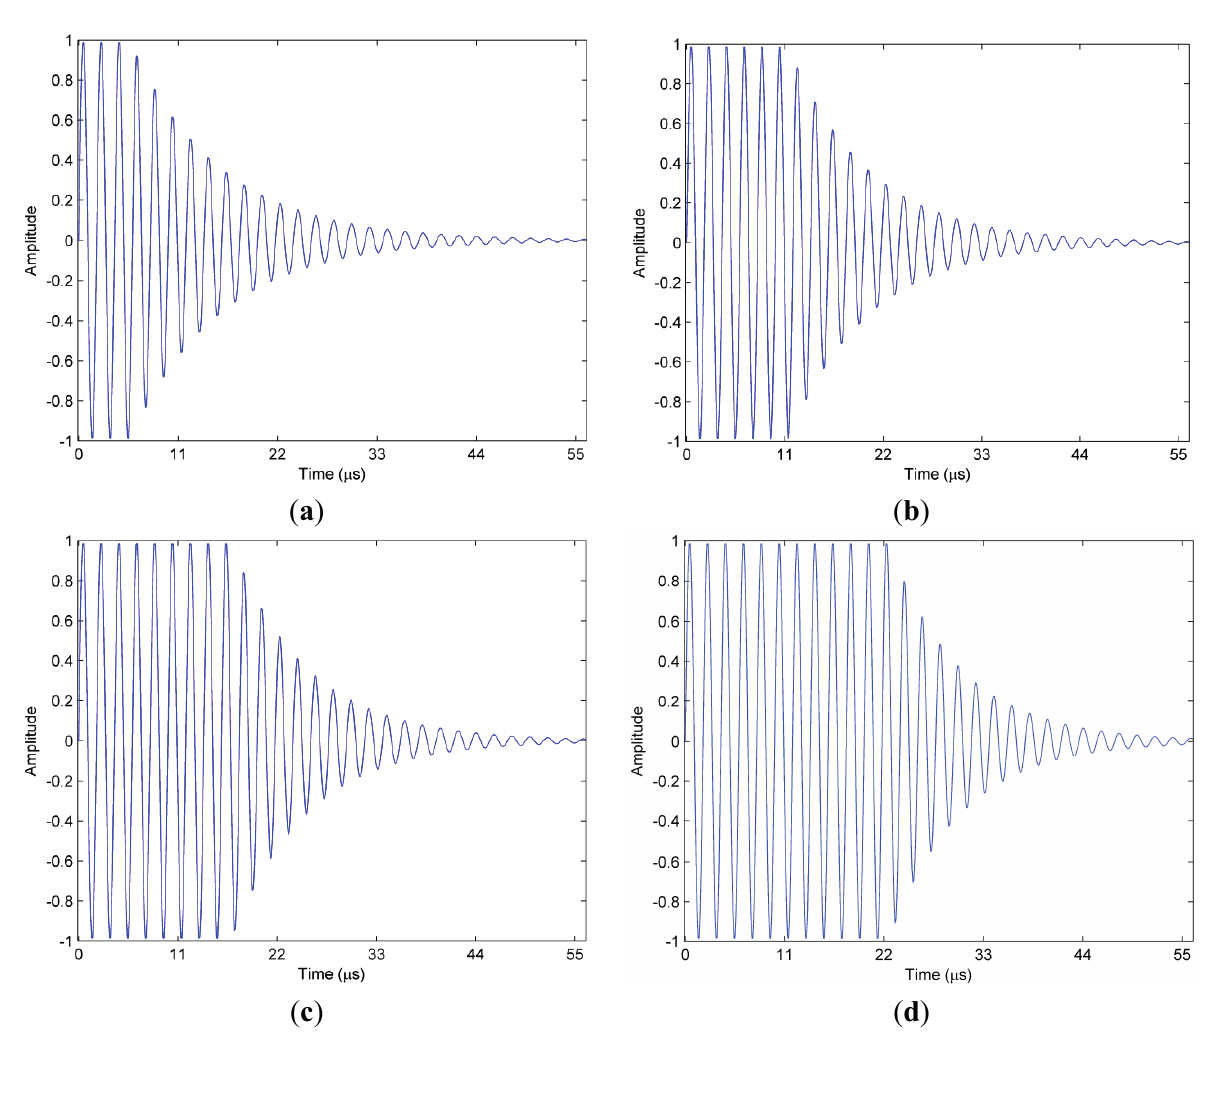
Figure 2. Hybrid signals with different undamped part ratio ( a ) 10% ( b ) 20% ( c ) 30% ( d )